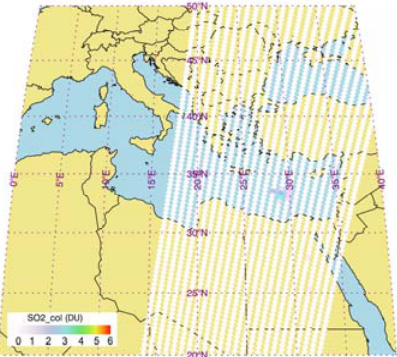
Figure 3: GOME-2 11 April 07.44 GMT DLR SO 2 column